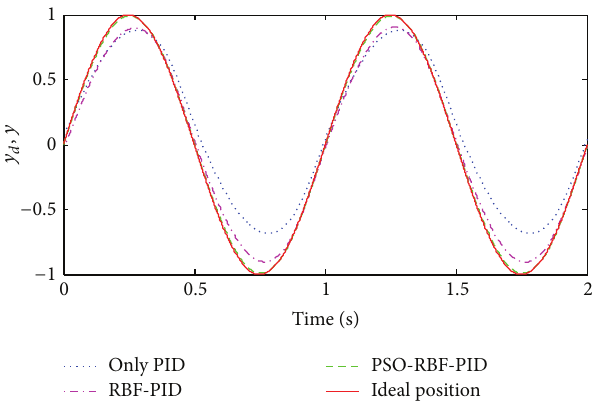
Figure 7: The tracking curves of three kinds of control algorithm.